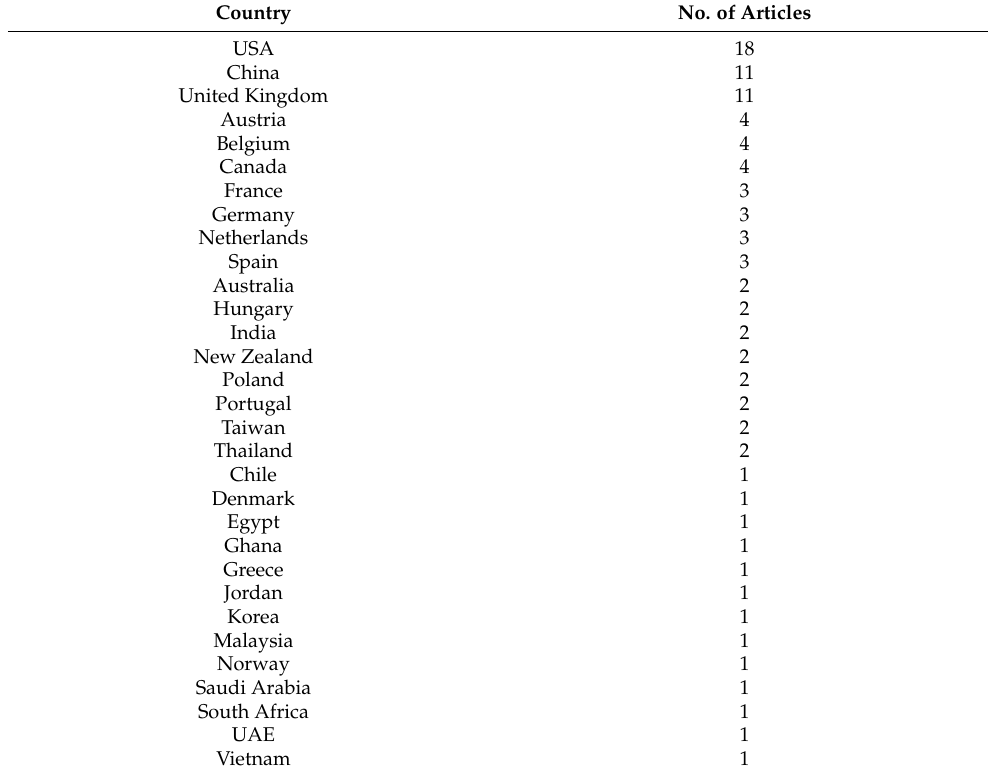
Table 2. Articles included in the review by